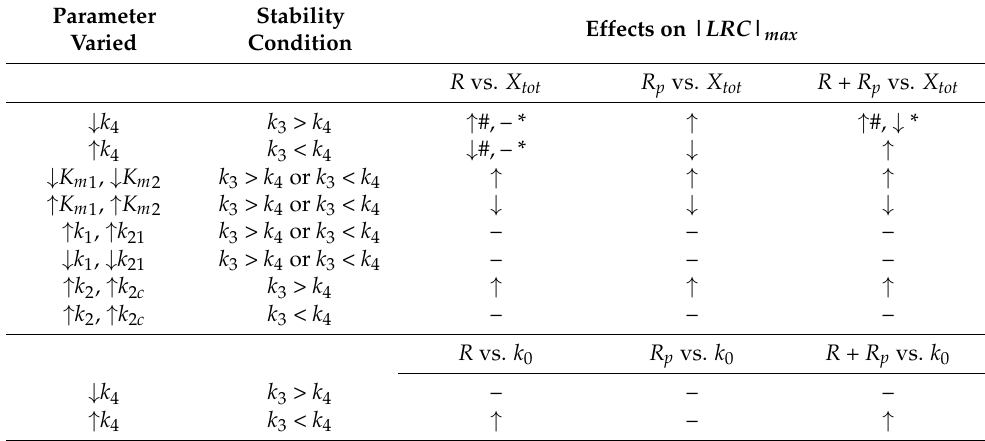
Table 3. Summary of effects of varying parameters on